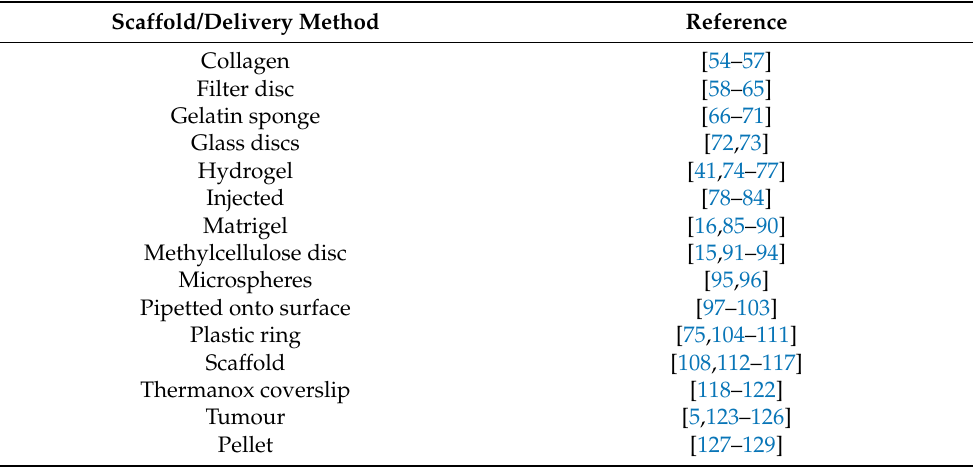
Table 1. Examples of various forms of scaffolds and delivery techniques for a variety of pro angiogenic and anti-angiogenic treatments used on the CAM